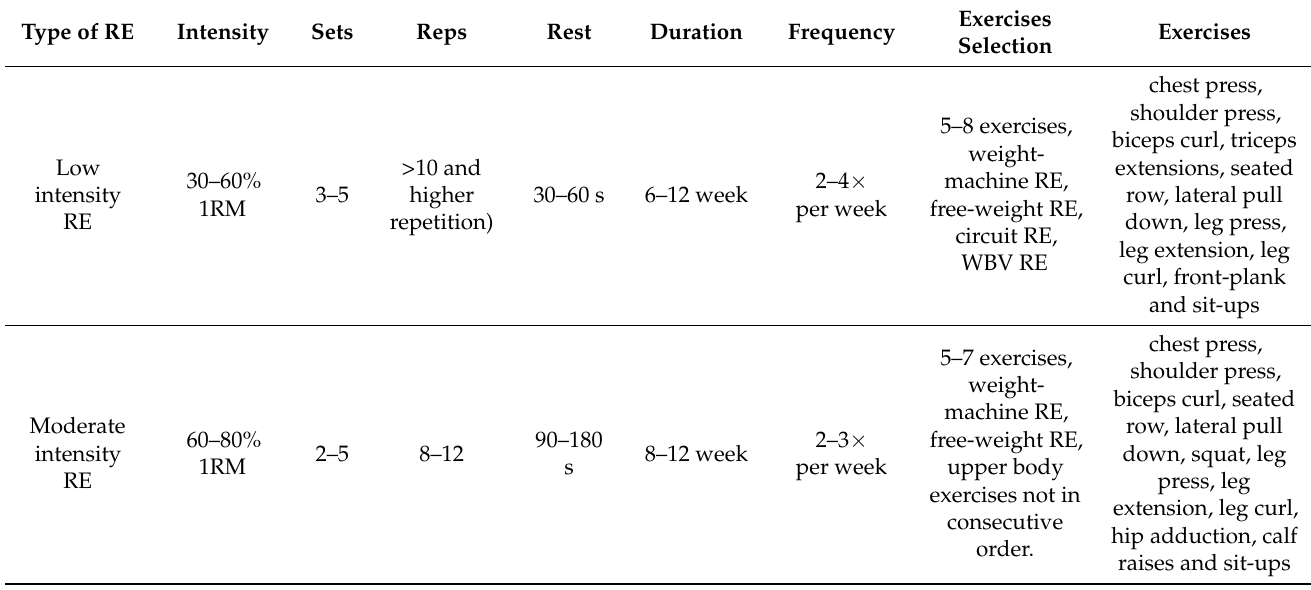
Table 3. Long-term resistance training recommendations for arterial stiffness decrease in healthy individuals. Type of RE Intensity Sets Reps Rest Duration Frequency